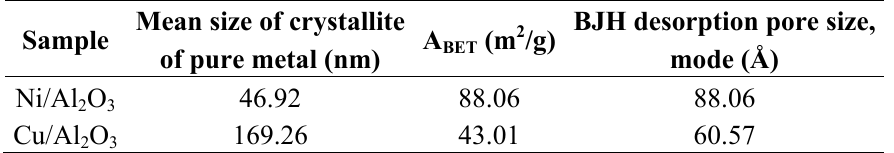
Table 1. Characteristics of nickel and copper particles deposited on alumina